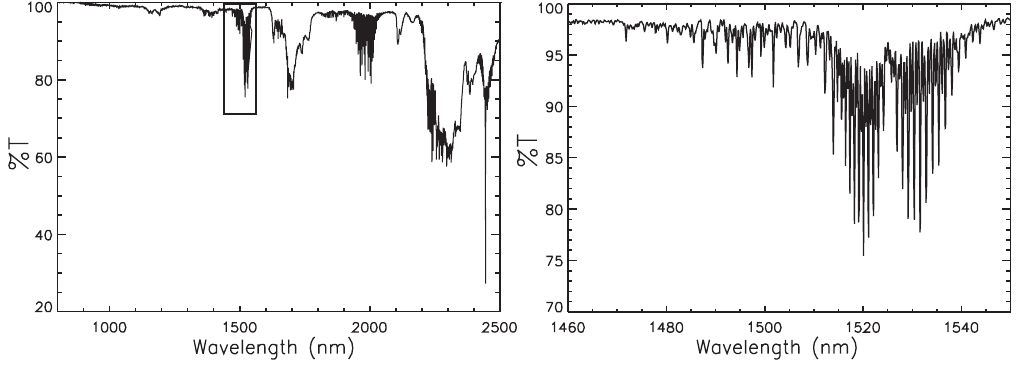
Figure 1. Left: Promising gas mixture with R ∼ 30000. Right: Zoom around 1500 nm corresponding to the black square in the left